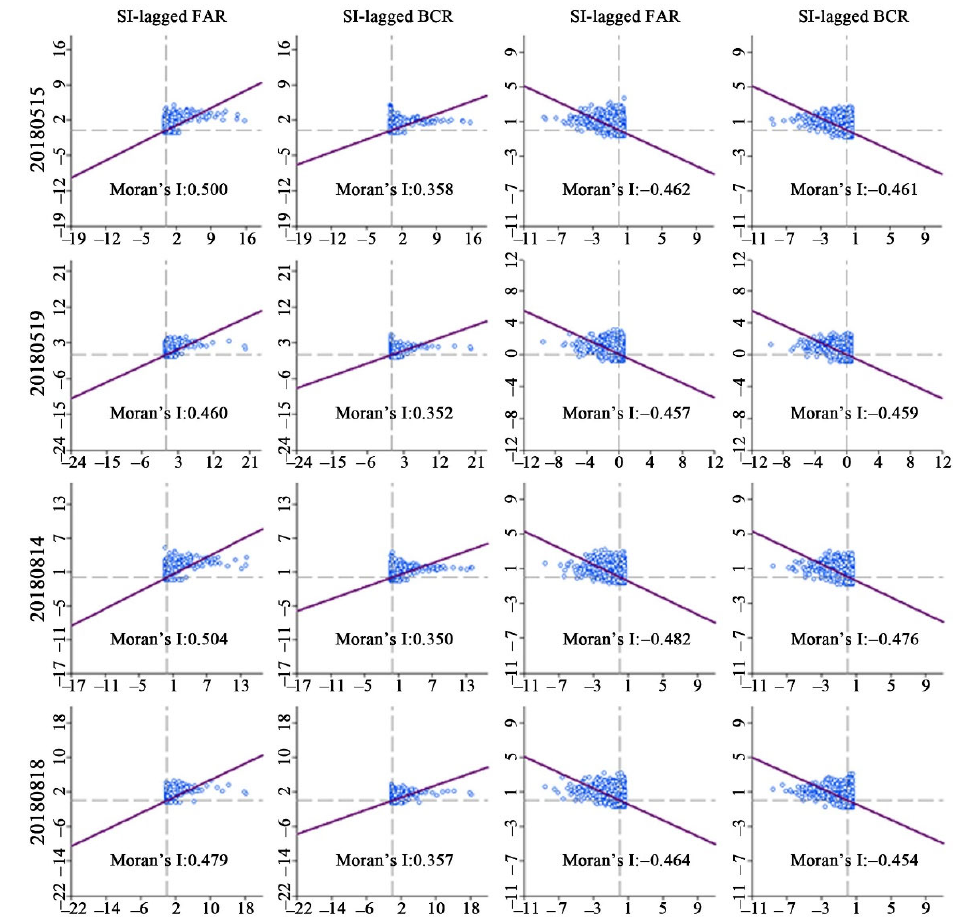
Figure 4. The global Moran’s I between the population source-sink and urban land use intensity in the morning peak.